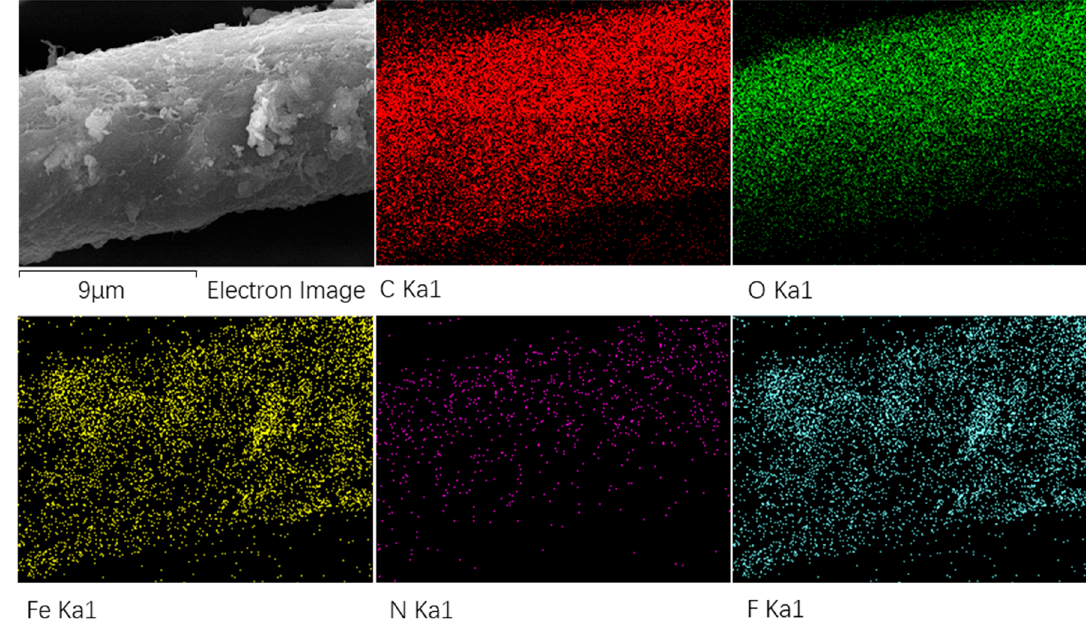
Figure 4. EDS mapping images of Fe 3 O 4 ‐ modified cotton fabrics after fluorination treatment with FAS.